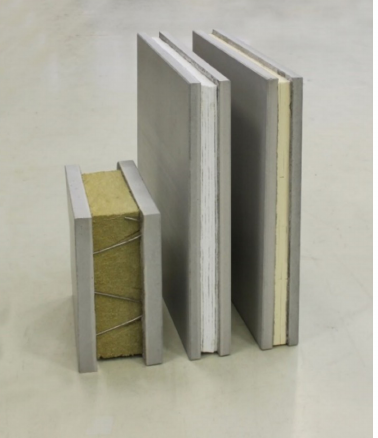
Figure 5. Comparison of a conventional reinforced concrete wall element ( left ) with two CRC wall elements with different aerogel insulation ( middle , right